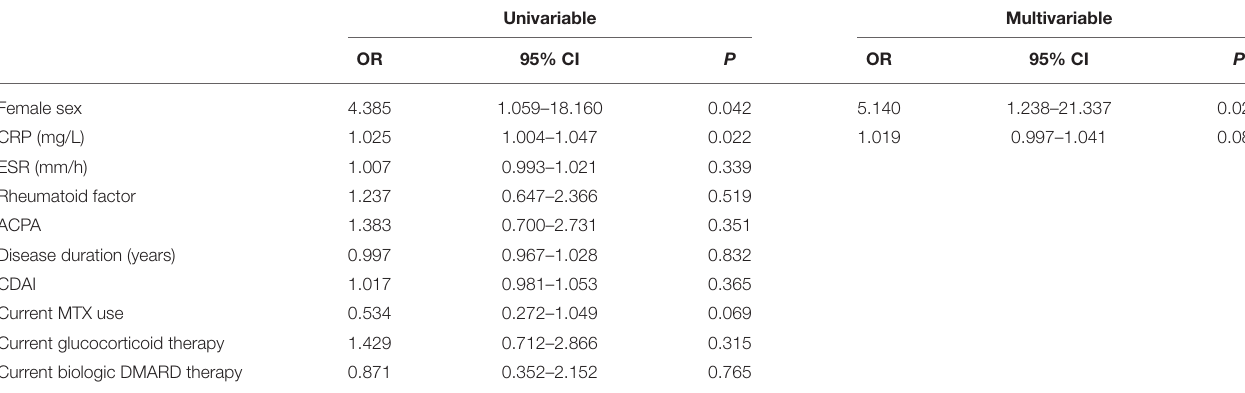
TABLE 4 | RA-specific variables significantly associated with LVH: univariable and multivariable Cox regression